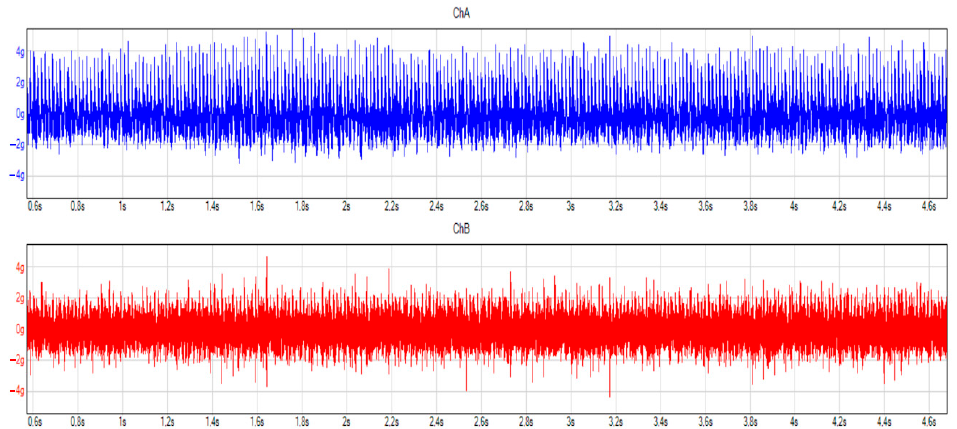
Figure 14. Vibrations in the time domain after the oil change, 50 km/h, 3rd gear. Blue and red colors mean the different considered and applied channels, during the measurement.